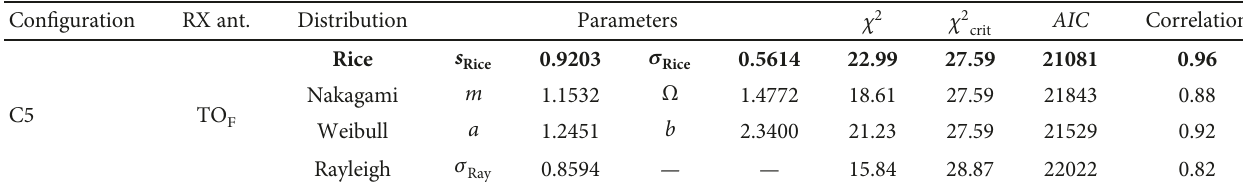
(b) Results of the fast fading distribution fi tting for con fi gurations C5 – C9 Con fi guration RX